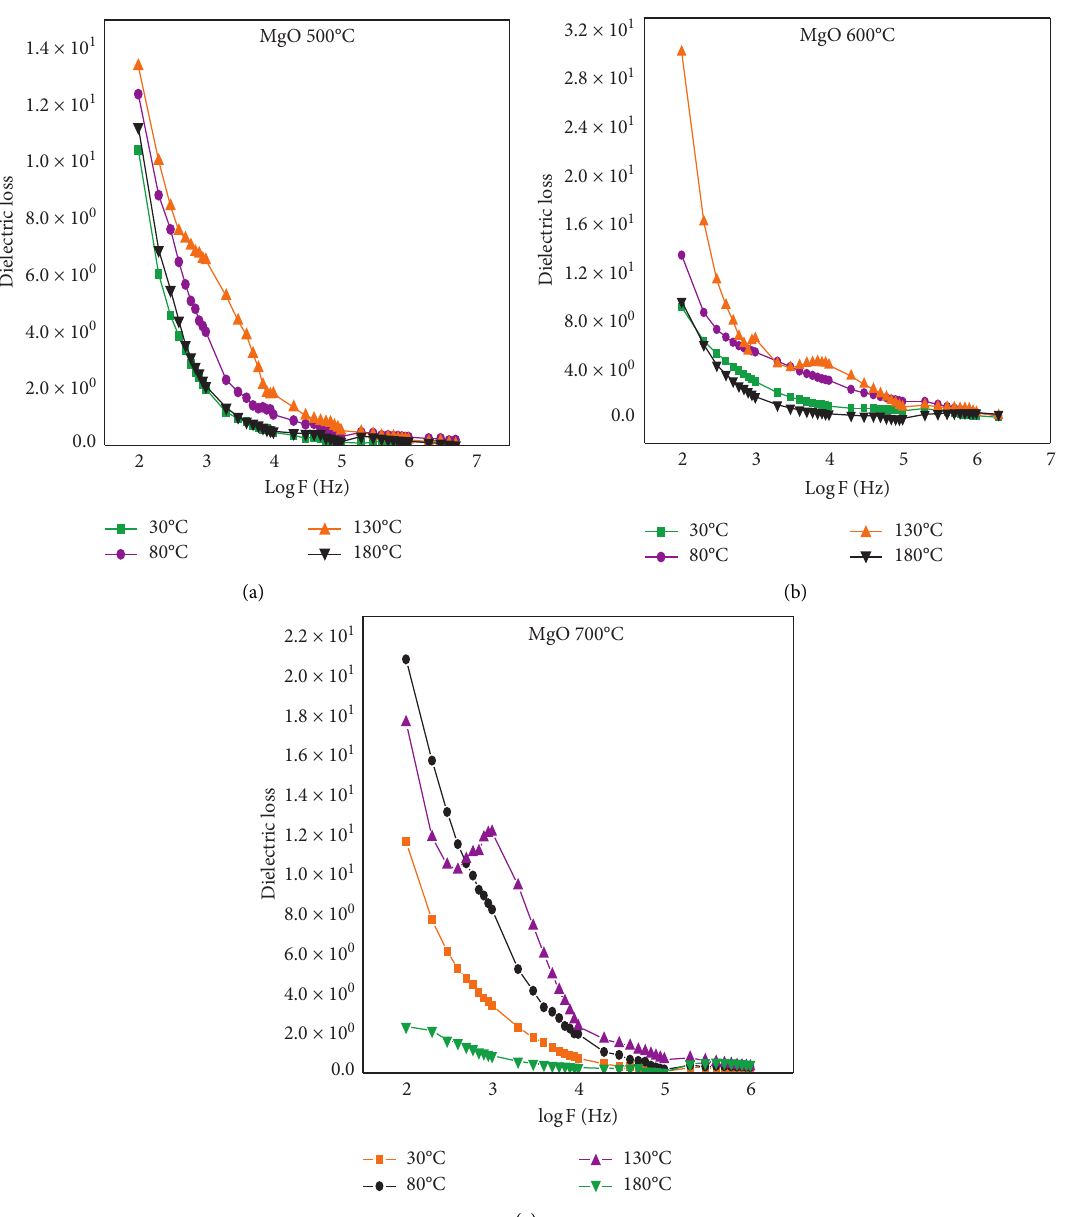
Figure 15: Dielectric loss of MgO nanoparticles at 500 ° C (a), 600 ° C (b), and 700 ° C (c) with different